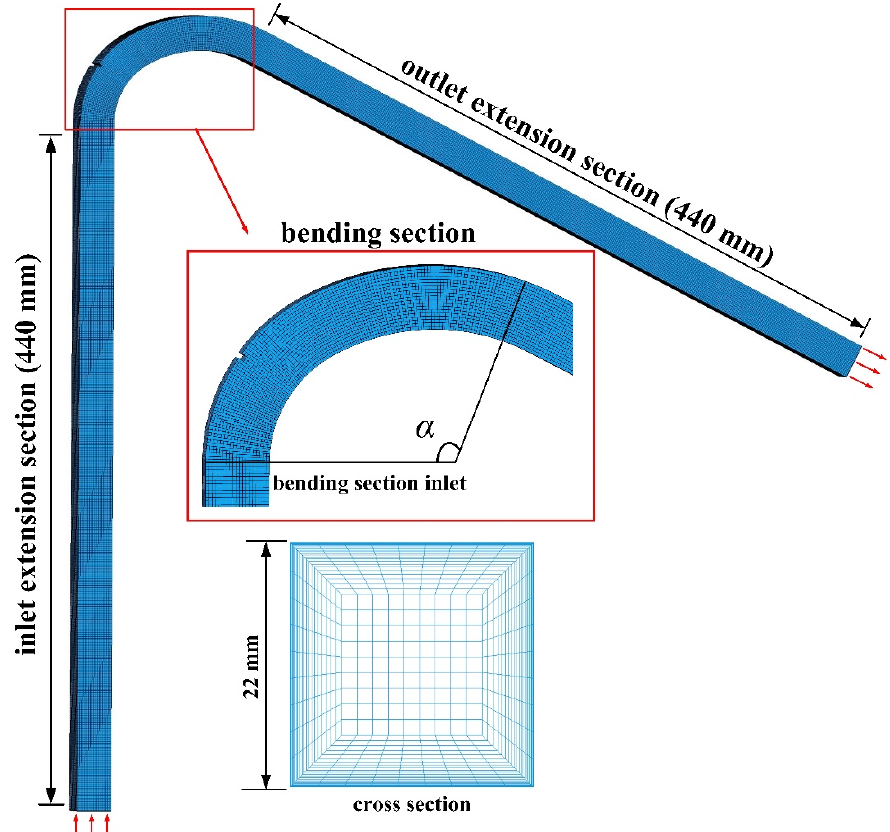
Figure 3. Schematic diagram of grid model.